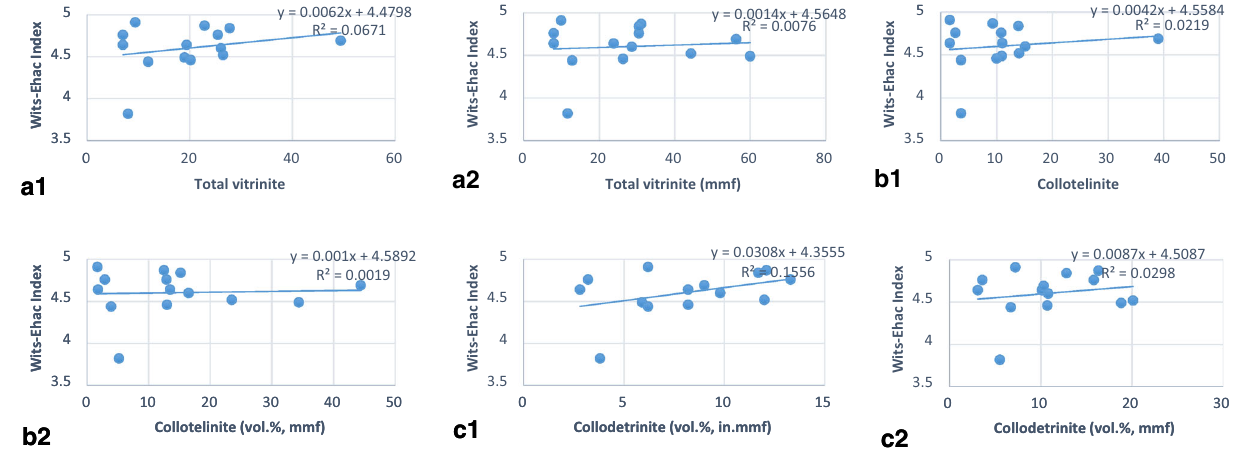
Fig. 4 Influence of vitrinite and its group on spontaneous combustion liability